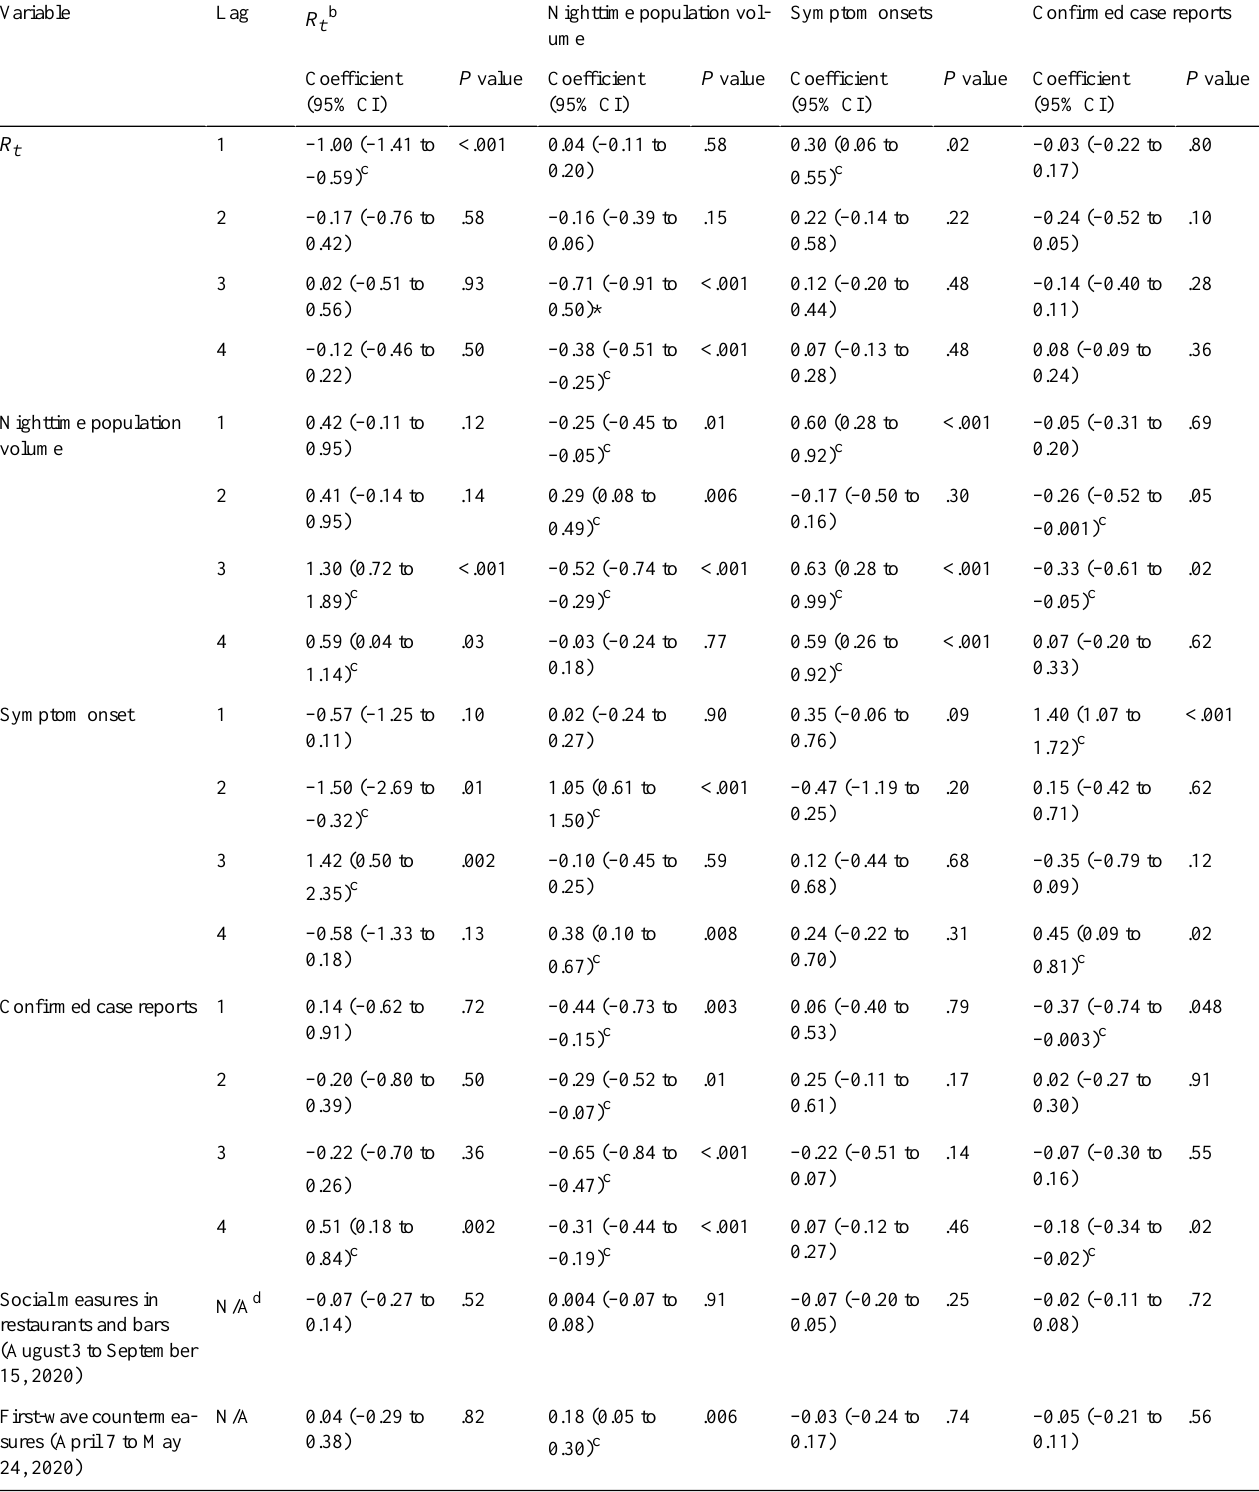
Table 1. Results of vector autoregression analysis on the number of confirmed case reports, symptom onsets, nighttime population volume, and R t per week.